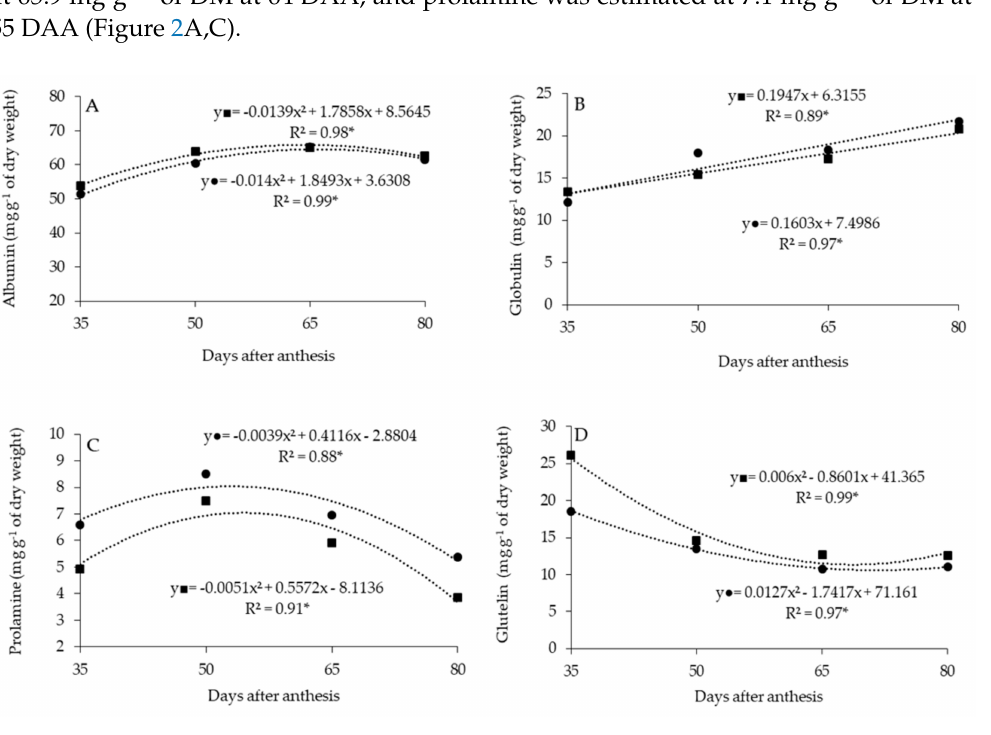
Figure 2. Albumin ( A ), globulin ( B ), prolamine ( C ) and glutelin ( D ) content in sweet pepper seeds, as a function of maturation stage, without ( • ) and with ( (cid:4) ) post-harvest resting of fruits. * significant difference at 5%